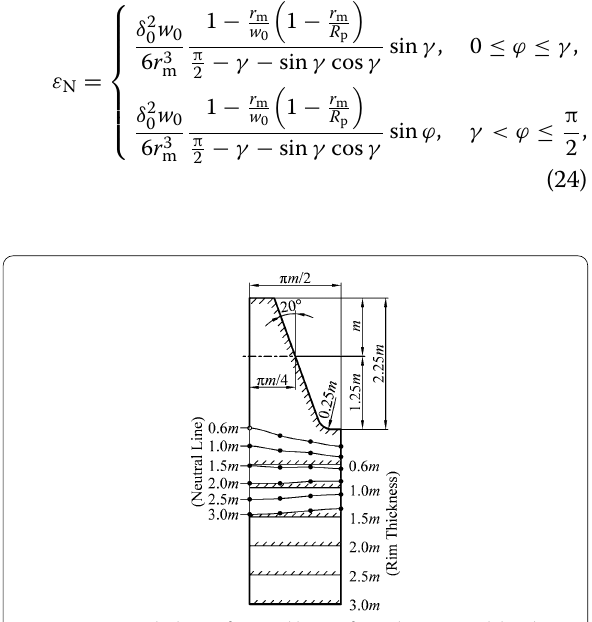
Figure 23 Morphology of neutral layer of simple trapezoidal